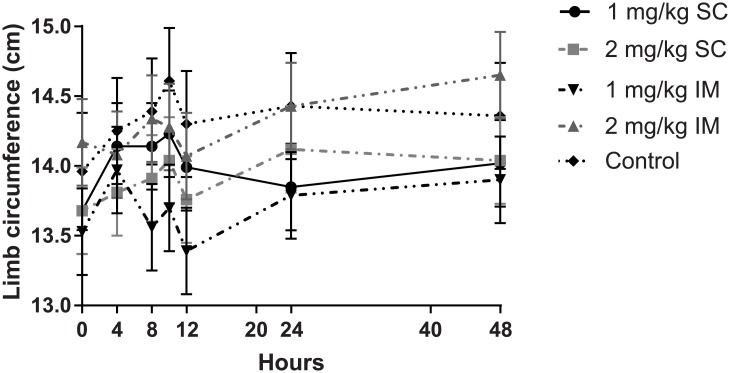
Injected limb circumference at selected time-points for control group and all meloxicam treatment groups.Only the 1.0 mg/kg IM treatment was significantly different to controls at both time-points at 10 and 12 h (P < 0.05).